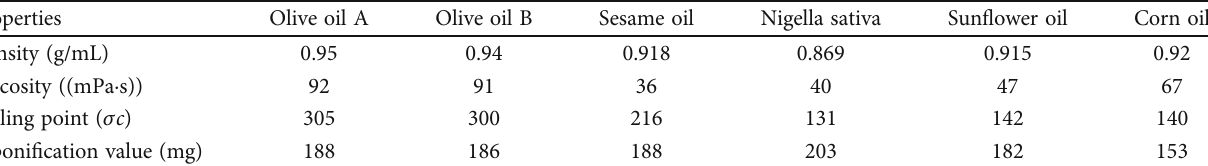
Table 1: Physicochemical properties of oils at room temperature 35 σ C .